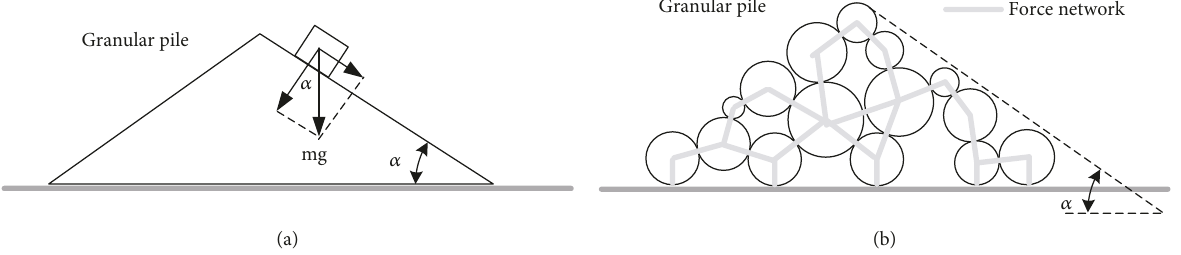
Figure 9: Force diagram of repose angle for (a) single particulate solid and (b) a cluster of